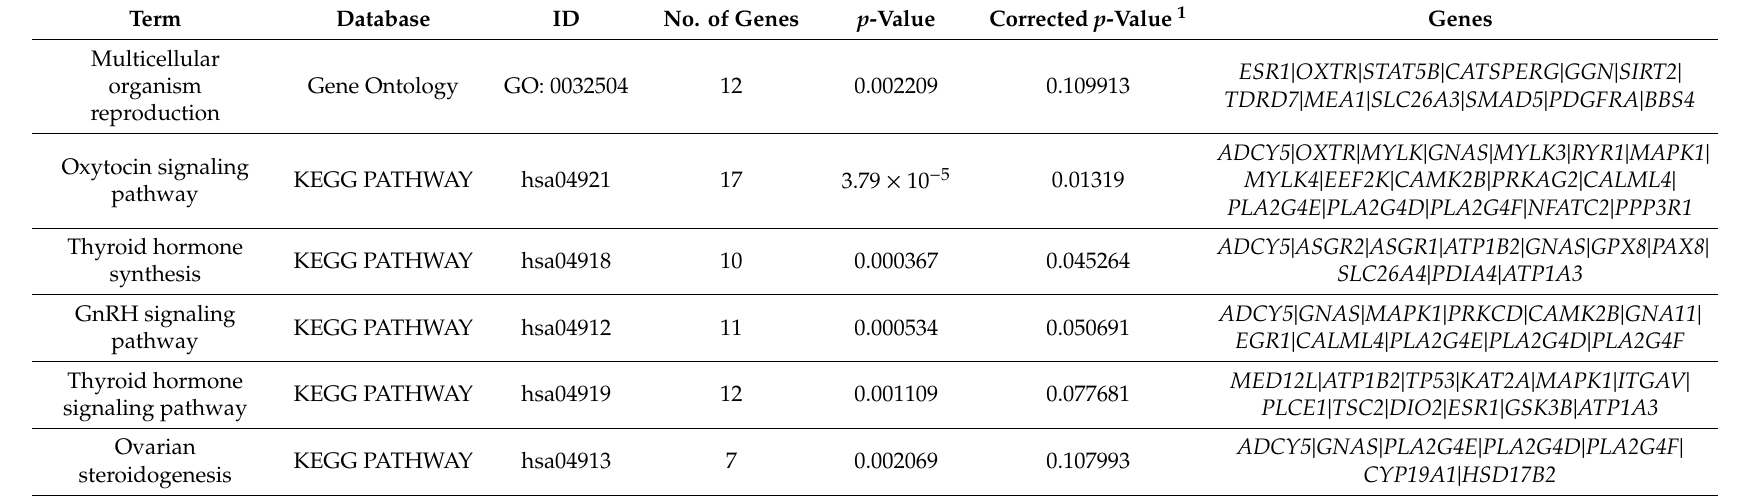
Table 2. GO terms and pathways related to reproduction involved genes in selective regions in four sheep